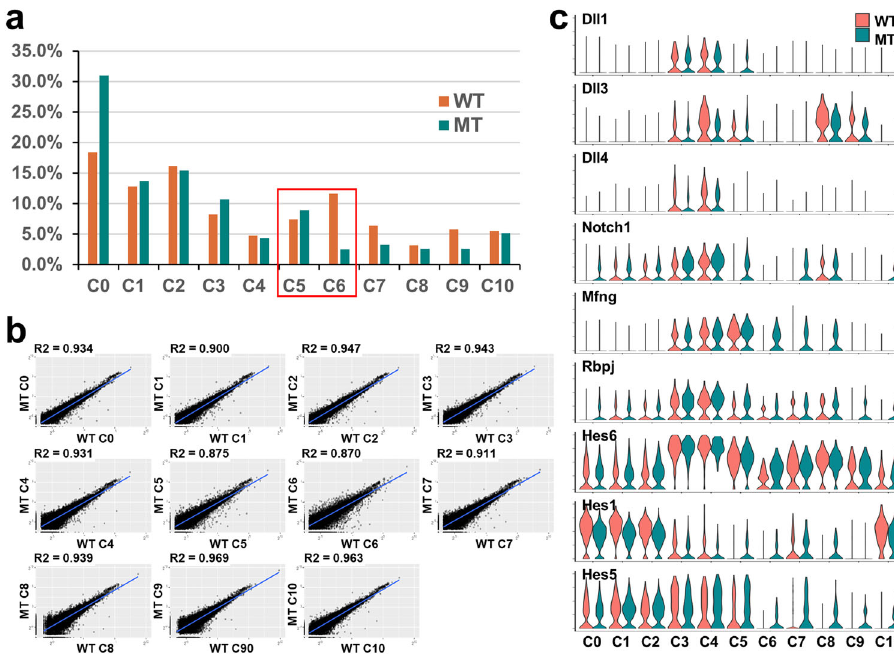
Fig. 7 Comparison of wild-type and Atoh7 -null clusters. a Proportions of cells in each wild-type (WT, red) and Atoh7 -null (MT, blue) clusters. Nascent retinal ganglion cells (RGCs) (C5) and differentiated RGCs (C6) are highlighted by a red box. Note there is no major change in the proportion of cells in C5, but a marked reduction in C6. Source data are provided. b Scatter plots comparing gene expression in corresponding pairs of WT and MT clusters. The correlation coef fi cients (R2) are shown for each pair. The C5 and C6 pairs have the lowest R2 values, indicating the most changes in gene expression. c Violin plots showing cluster-speci fi c changes in expression of the Notch pathway genes. Note the distinct expression patterns of individual genes and differential expression changes in the MT clusters (see text for